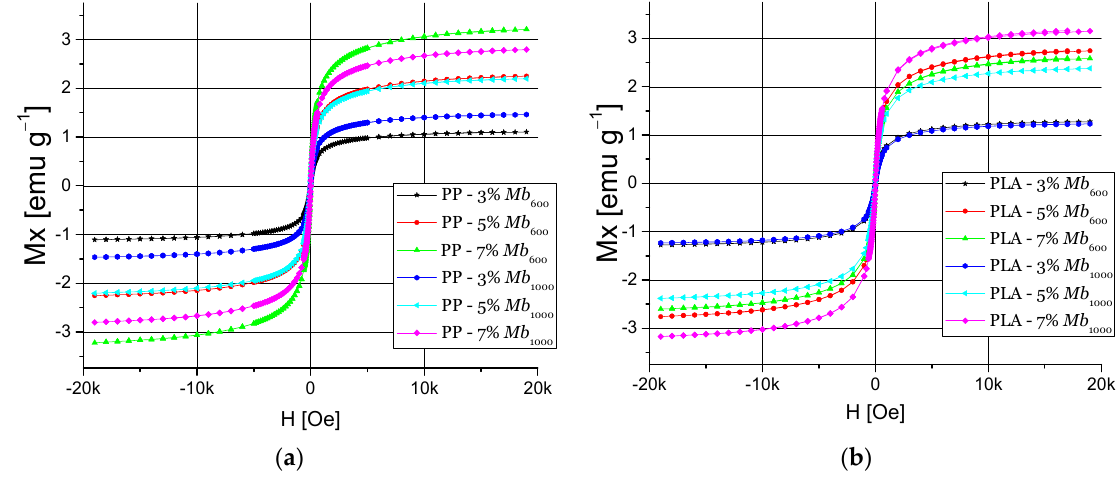
Figure 7. Magnetic hysteresis cycles: ( a ) PP:Mb 600 and Mb 1000 and ( b ) PLA:Mb 600 and Mb 1000 nanocomposites.